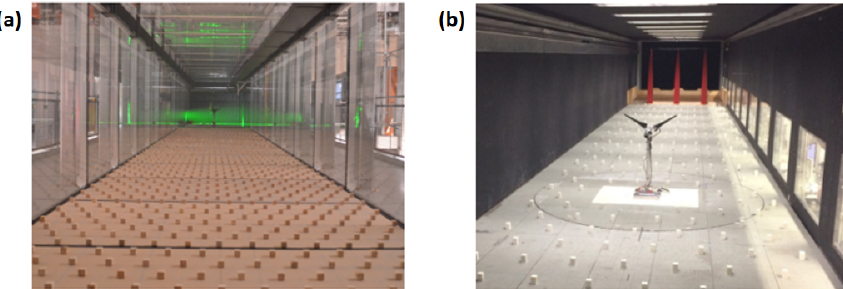
Figure 6. The UTD BLAST atmospheric boundary layer test section looking downstream towards the model (a) and the TUM atmospheric boundary layer test section looking upstream (b)